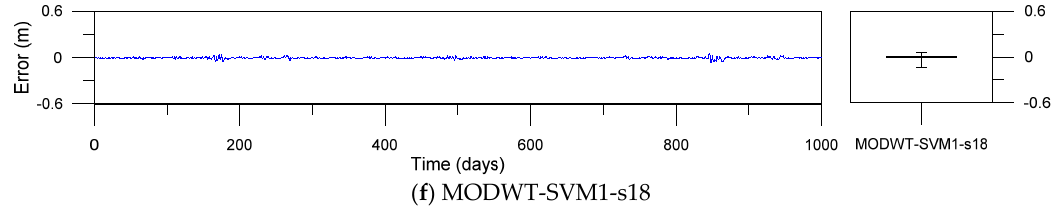
Figure 14. Error time series plots and error boxplots for the MODWT-based models.